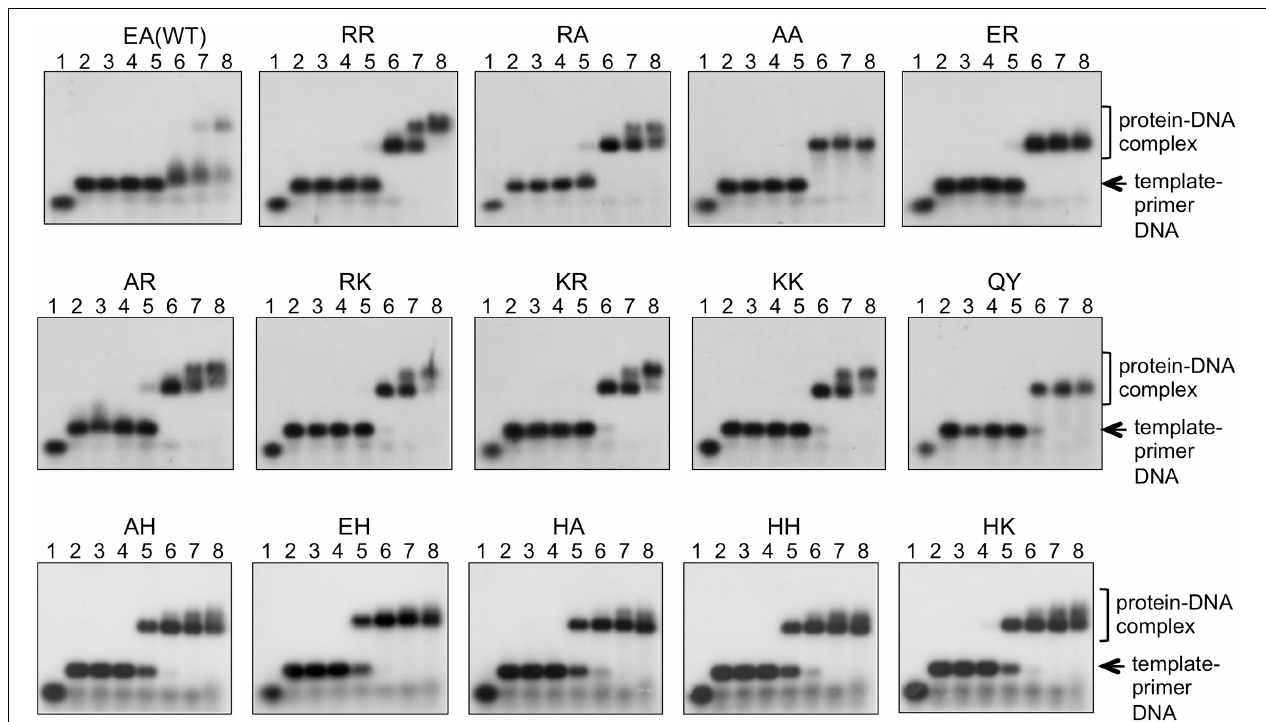
panel. Lane 1 was 32 P-labeled 27mer ssDNA. Lane 2 had no protein with primed DNA. Lanes 3 ∼ 8 contained 0.4, 1.6, 6.3, 25, 100, and 400nM enzyme, respectively.